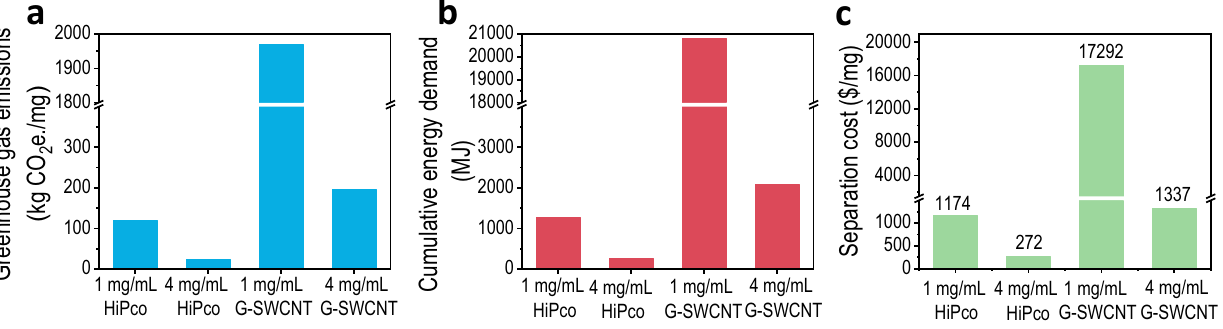
SWCNTs from HiPco- and G-SWCNTs under different concentrations. The detailed calculation is presented in Supplementary Note